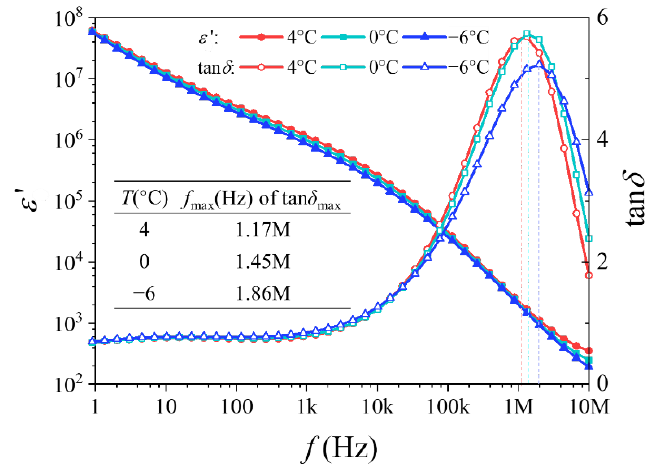
Figure 5. Dielectric spectrum during cooling from 4 °C to −6 °C.